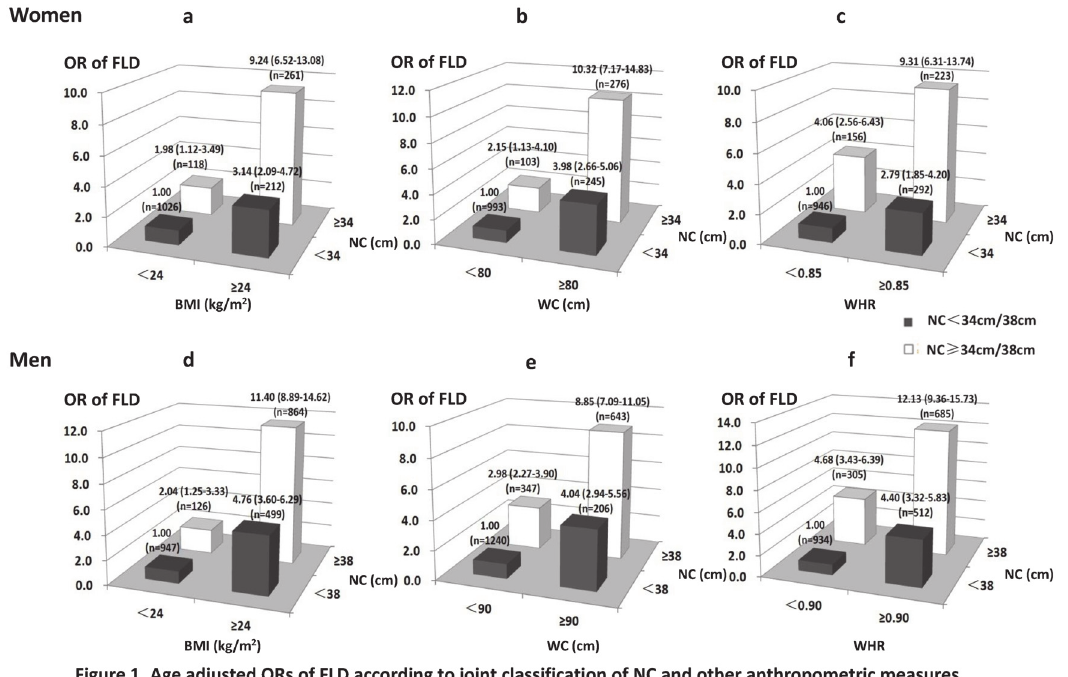
Fig 1. Age-adjusted ORs of FLD according to joint classification of NC and other anthropometric measures.